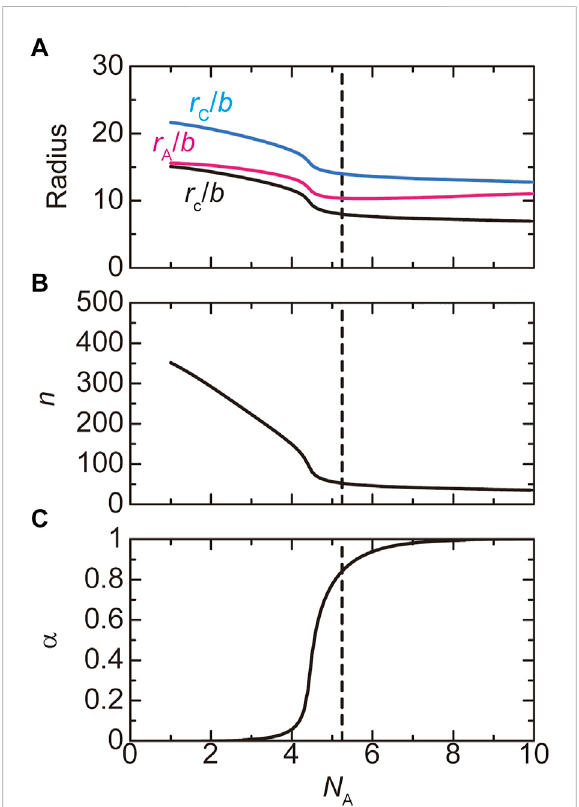
FIGURE 6 The radius (A) , the number n of copolymers (B) , and the fraction α of A blocks in the shell (C) of paraspeckles are shown as functions of the number N A of units of the A blocks. In a, we showed the radius r c of the core of a paraspeckle (black), the distance r A between the top of the A blocks and the center of the paraspeckle (magenta), and the distance r C between the top of C blocks and the center of the paraspeckle (cyan). The (natural) logarithm log ( k tx / k 0 ) of the production rate of copolymers is fi xed to -12.0. The values of parameters used for the calculations are N N χ χ v A / b 3 (cid:1) v C / b 3 = 1.0, and C B = 40.0, C = 15.0, s = B = 0.5, AB = 1.0, 1.5. The vertical broken line indicates the critical number N Ac of units in A